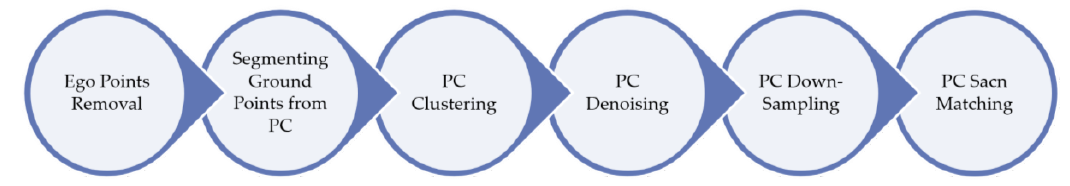
Figure 2. Point Cloud Preparation Flowchart.